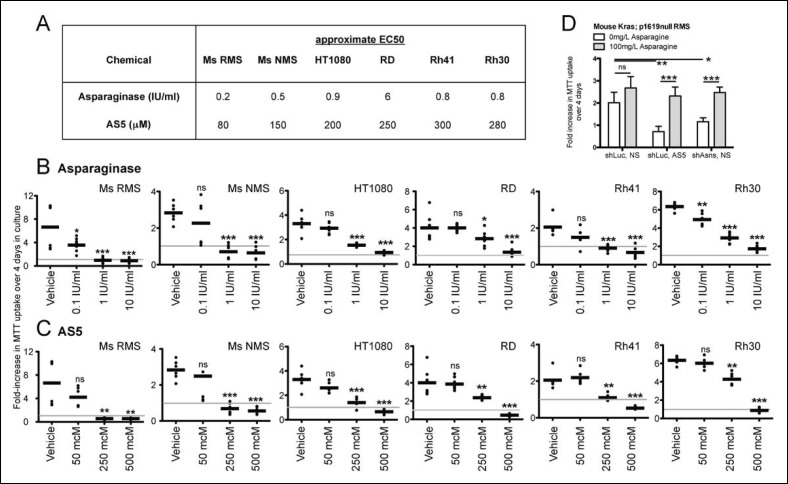
Inhibition of mouse and human sarcoma cell growth in vitro by chemical compounds interfering with Asparagine homeostasis.(A–C) Proliferation assays of mouse (Ms RMS, Ms NMS) and human (HT1080, RD, Rh41, Rh30) sarcoma cell lines exposed to the indicated doses of chemical modulators of Asparagine homeostasis: (A–B) Asparaginase or (A,C) AS5. Both chemicals were diluted in 0.9% NaCl (Normal Saline (NS)) as vehicle. (D) Chemical and genetic ASNS inhibition was reversed by exogenous supplementation with 100 mg/L asparagine in the tissue culture medium (100 mg/L, which corresponds to 757 μM; compared to normal asparagine concentrations in mouse and human plasma of 29 μM and 55 μM, respectively (Cooney et al., 1970)). Data were evaluated for statistical significance by T-tests (ns p≥0.05, * p<0.05, ** p<0.01, *** p <0.001). See Figure 4—figure supplement 1 for ASNS expression in human sarcoma cells.